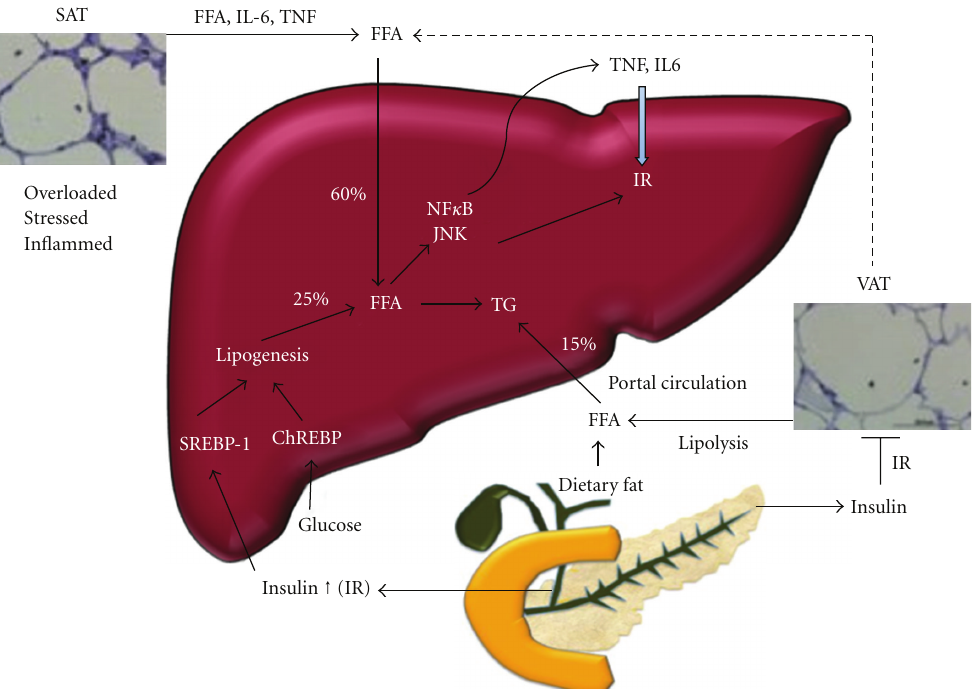
Figure 1: Mechanism of hepatic steatosis, adapted from Larter et al. 2010 [12], showing also interactions between adipose tissue in di ff ering sites with liver in the development of insulin resistance (IR). FFA: free fatty acids; SAT: subcutaneous adipose tissue; VAT: visceral adipose tissue; TG: